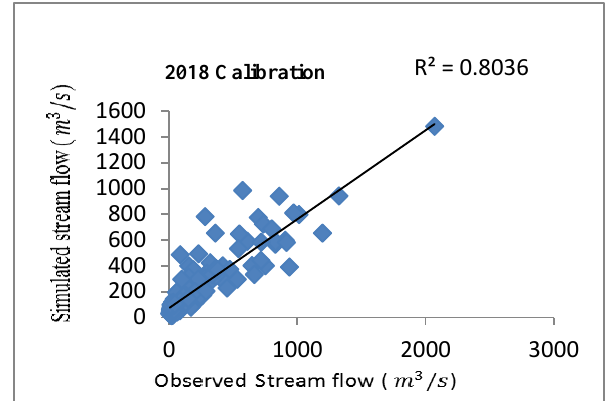
Table 13 Statistical coefficient values for monthly runoff Scatter plots are plotted for observed against simulated runoff values which are shown in figures 14, 15, 16, 17. Line graphs are plotted for observed and simulated streamflows against time for the years 2003 and 2018 and are shown in Figs. 18, 19, 22, 23.